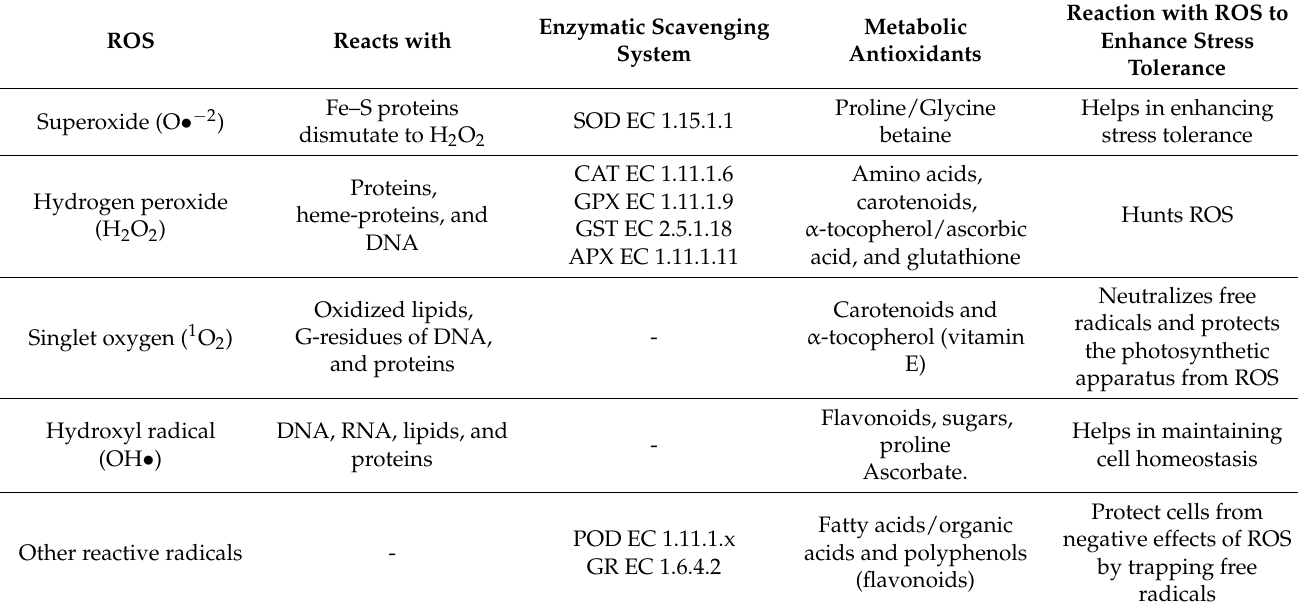
Table 1. Chemical reaction of enzymatic and metabolic antioxidants with reactive oxygen species (ROS). ROS Reacts with